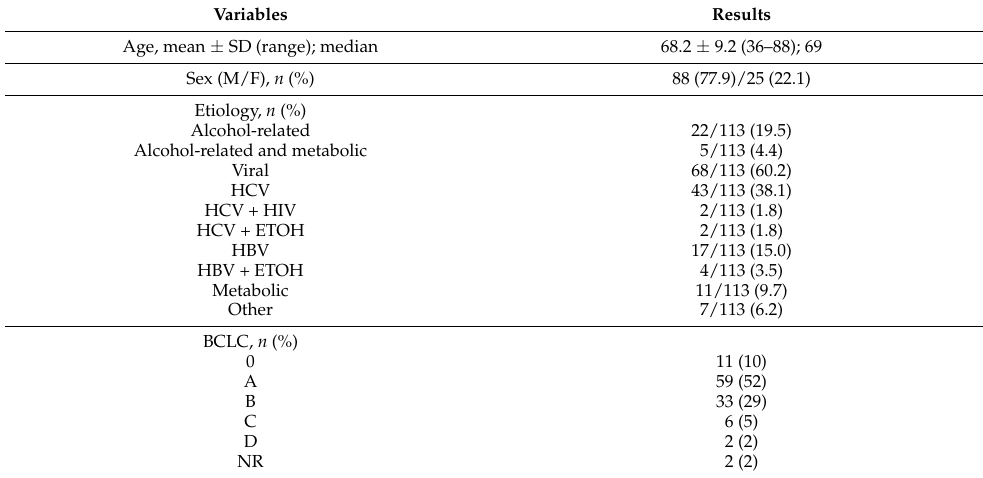
Table 1. Population